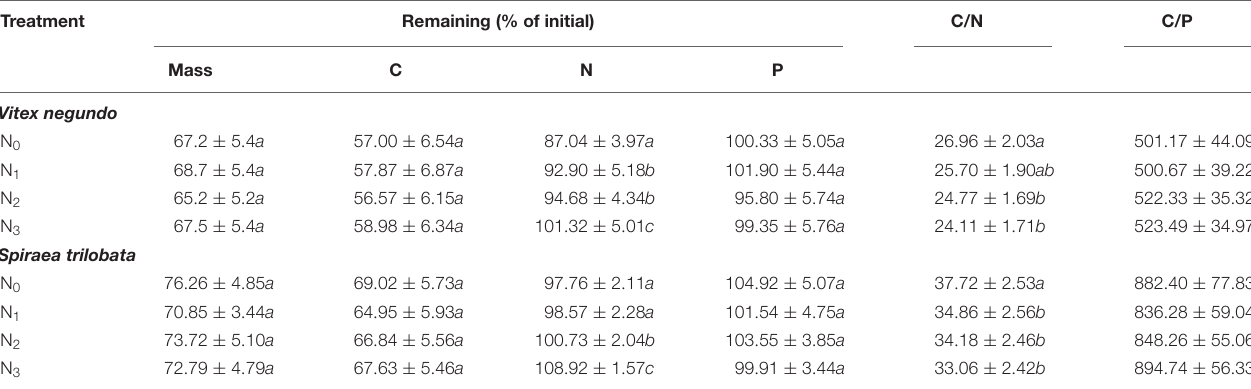
Each column represents the mean value across all sampling dates in all treatments. Different letters indicate significant differences among different treatments in each community (repeated-measures ANOVA with Tukey’s HSD test, α = 0.05, n = 3). N 0 , control; N 1 , low N; N 2 , moderate N; and N 3 , high N.